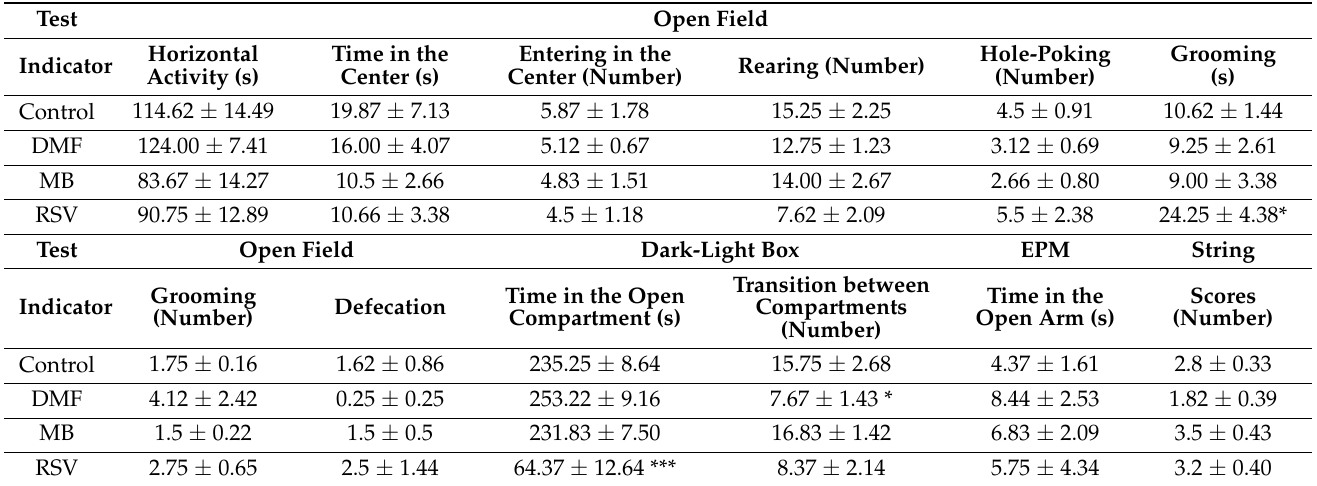
Table 1. Results of physiological tests: open field, dark-light box, elevated plus-maze (EPM), string test. Test Open